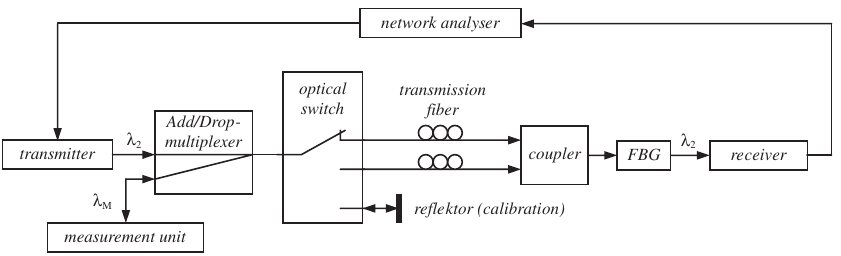
FIG. 13. Setup to verify the accuracy of the delay measurement by means of a control